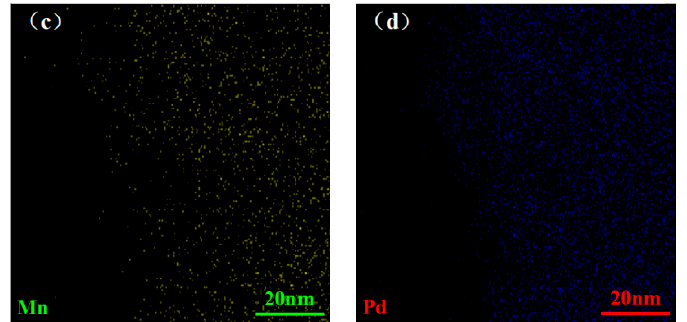
Figure 3. TEM images ( a , b ) of Pd/ γ -MnO 2 , and energy dispersive x-ray spectroscopy (EDX) mapping images ( c , d ) of Mn and Pd elements on Pd/ γ -MnO 2 .